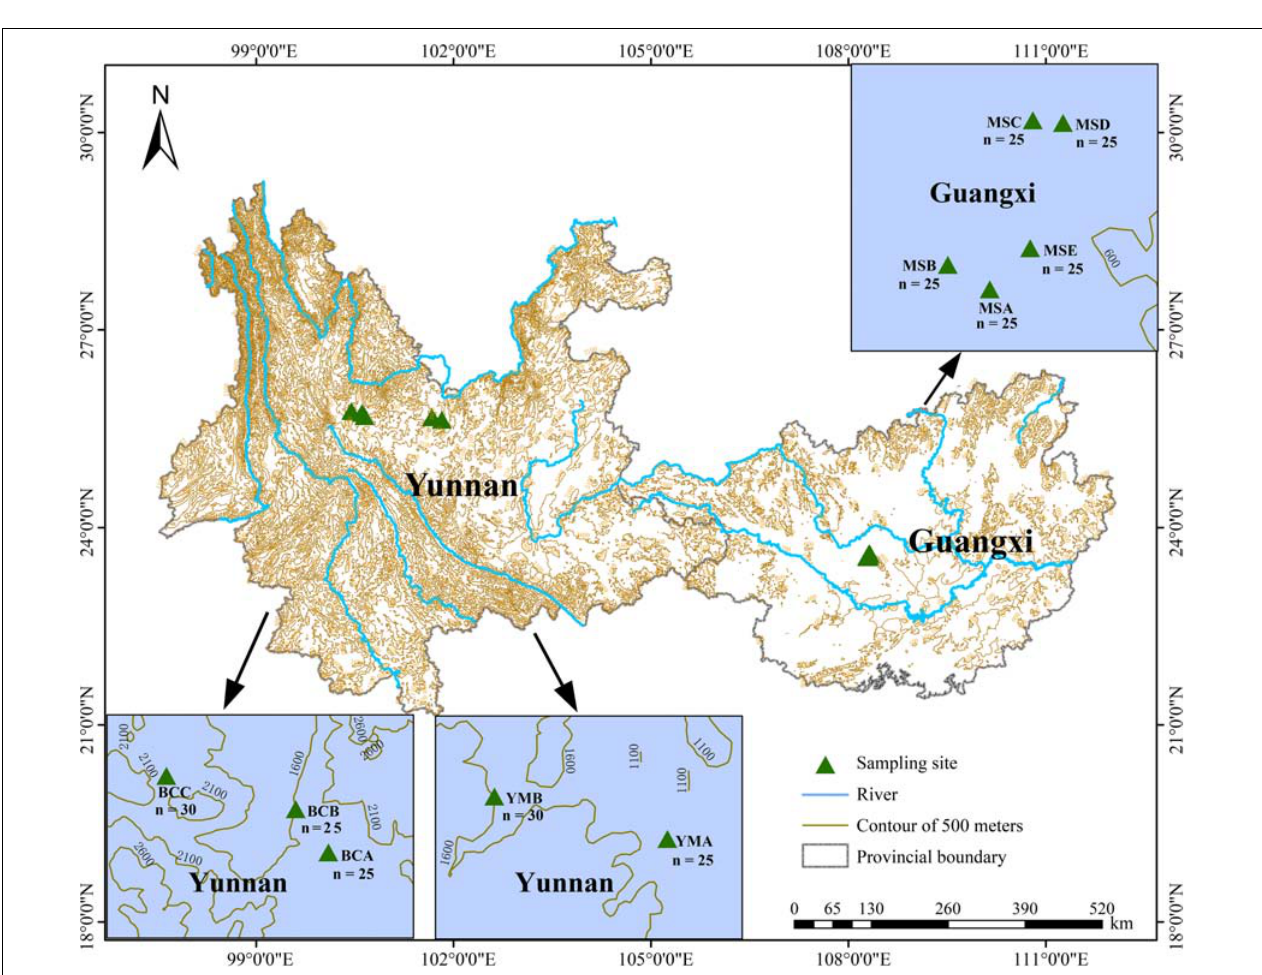
FIGURE 1 | Geographical distribution of the 10 populations of P. emblica in this study. The populations YMA, YMB, respectively, represent sampling sites A (25 ◦ 37 (cid:48) 56 (cid:48)(cid:48) N, 101 ◦ 49 (cid:48) 12 (cid:48)(cid:48) E, 1174.8 m a.s.l.) and B (25 ◦ 40 (cid:48) 09 (cid:48)(cid:48) N, 101 ◦ 40 (cid:48) 09 (cid:48)(cid:48) E, 1245.8 m a.s.l.) in Yuanmou County, Yunnan Province; the populations BCA, BCB, and BCC respectively represent sampling sites A (25 ◦ 41 (cid:48) 20 (cid:48)(cid:48) N, 100 ◦ 38 (cid:48) 39 (cid:48)(cid:48) E, 1667.7 m a.s.l.), B (25 ◦ 44 (cid:48) 15 (cid:48)(cid:48) N, 100 ◦ 36 (cid:48) 22 (cid:48)(cid:48) E, 1627.8 m a.s.l.), and C (25 ◦ 45 (cid:48) 57 (cid:48)(cid:48) N, 100 ◦ 26 (cid:48) 28 (cid:48)(cid:48) E, 1742.1 m a.s.l.) in Binchuan County, Yunnan Province; the populations MSA, MSB, MSC, MSD, and MSE respectively represent sampling sites A (23 ◦ 33 (cid:48) 02 (cid:48)(cid:48) N, 108 ◦ 17 (cid:48) 43 (cid:48)(cid:48) E, 253.1 m a.s.l.), B (23 ◦ 33 (cid:48) 31 (cid:48)(cid:48) N, 108 ◦ 16 (cid:48) 53 (cid:48)(cid:48) E, 221.0 m a.s.l.), C (23 ◦ 36 (cid:48) 23 (cid:48)(cid:48) N, 108 ◦ 18 (cid:48) 34 (cid:48)(cid:48) E, 214.2 m a.s.l.), D (23 ◦ 36 (cid:48) 20 (cid:48)(cid:48) N, 108 ◦ 19 (cid:48) 10 (cid:48)(cid:48) E, 339.2 m a.s.l.), and E (23 ◦ 33 (cid:48) 51 (cid:48)(cid:48) N, 108 ◦ 18 (cid:48) 31 (cid:48)(cid:48) E, 242.5 m a.s.l.) in Mashan County, Guangxi Province. The number of samples is detailed in the map of each